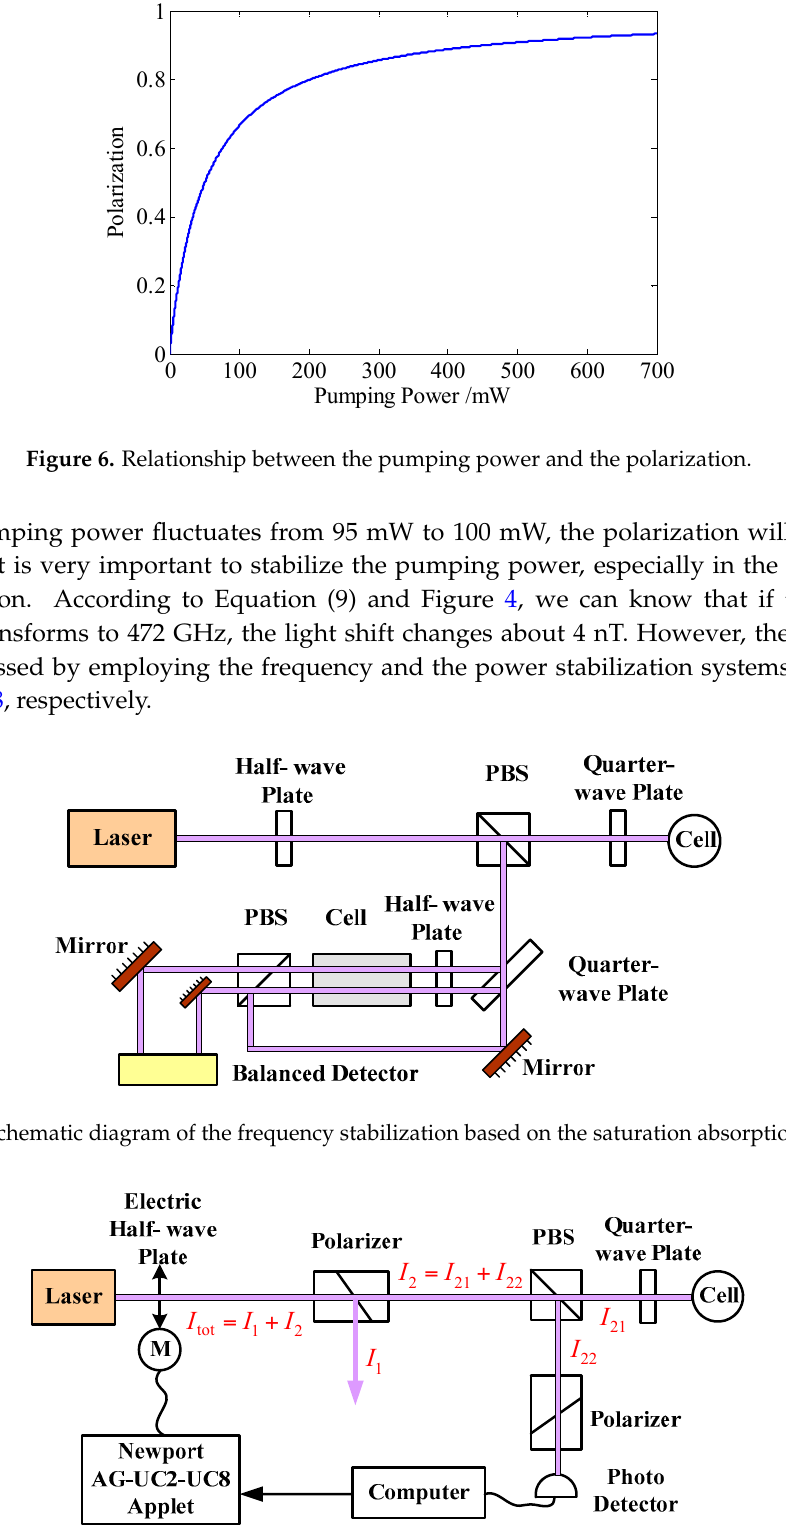
Figure 8. Schematic diagram of the power stabilization system. Newport AG-UC2-UC8 Applet is the piezo motor driven components.